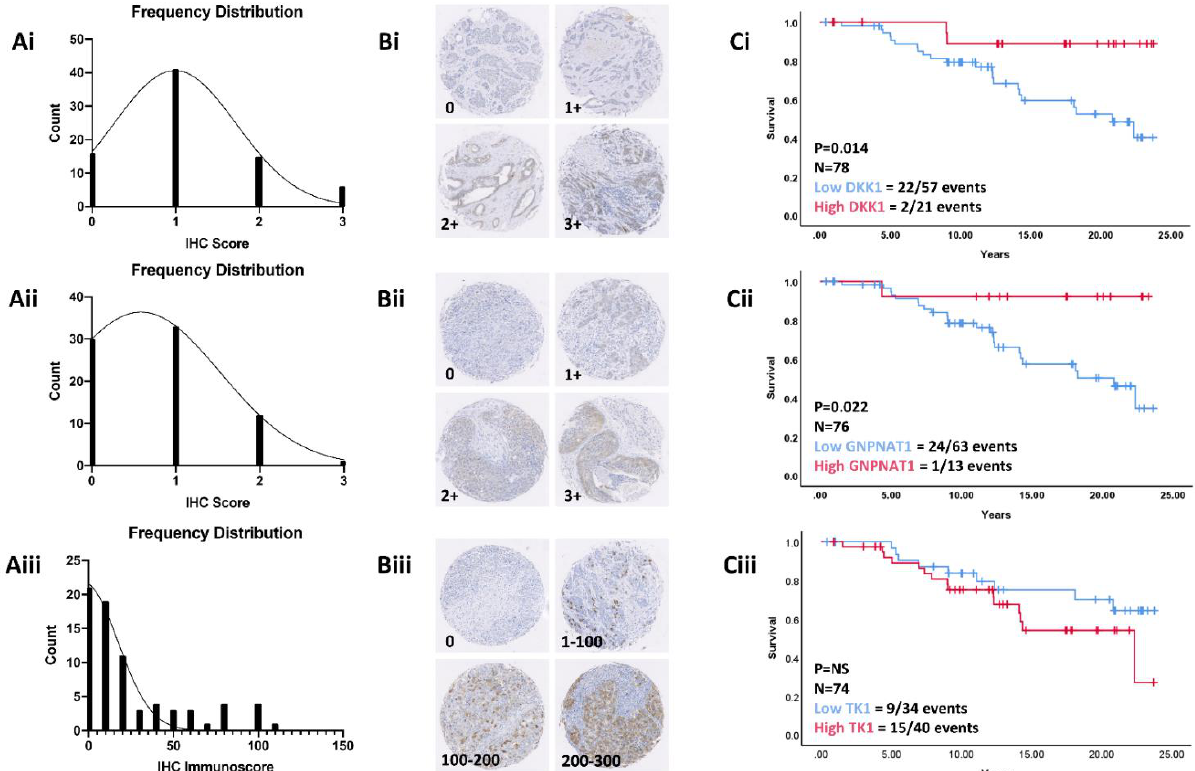
Figure 10. Validation in a retrospective patient cohort. ( A ) Frequency distribution histograms with gaussian regression curves fitted showing distribution of IHC grading histoscores of DKK1 (Ai) and GNPNAT1 (Aii), along with the distribution of IHC grading immunoscores for TK1 (Aiii), across a cohort ( n = 78) of post-menopausal ER + BC patients treated with surgery and adjuvant RT alone. ( B ) Representative images of IHC staining for DKK1 (Bi), GNPNAT1 (Bii) and TK1 (Biii). ( C ) Kaplan – Meier analysis of recurrence-free survival in relation to DDK1 (Ci), GNPNAT1 (Cii) and TK1 (Ciii) biomarker expression in the patient cohort. Median follow-up is 12.3 years. p -value derived from log-rank (Mantel-cox) test.